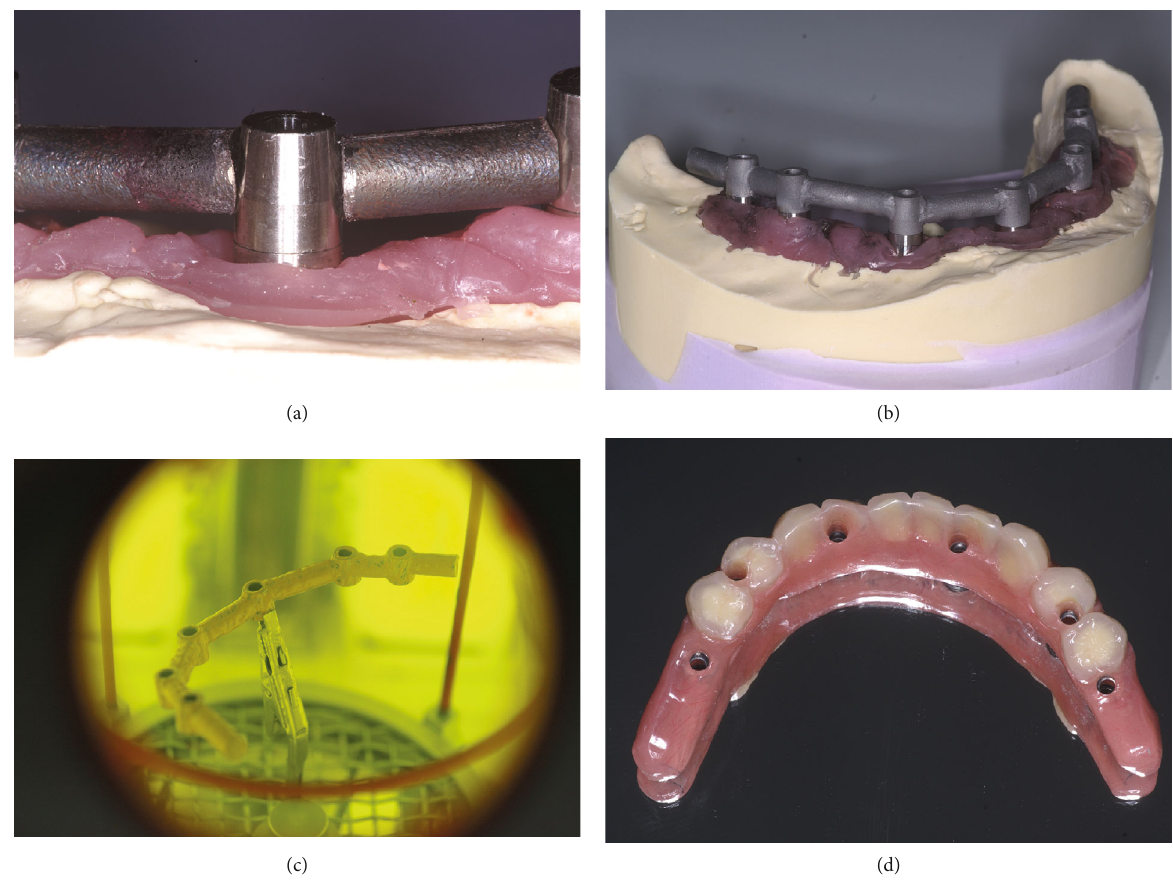
Figure 2: De fi nitive titanium implant framework fabricated using a laser-welding technique. (a) Segments of titanium rod adapted and inserted into the space between the titanium milled cylinders. (b) De fi nitive framework. (c) Pink opaquer layer was applied to increase prosthetic resistance under occlusal forces. (d) Interim prosthesis with acrylic teeth after fi nishing. Occlusion was shortened to the second premolar.